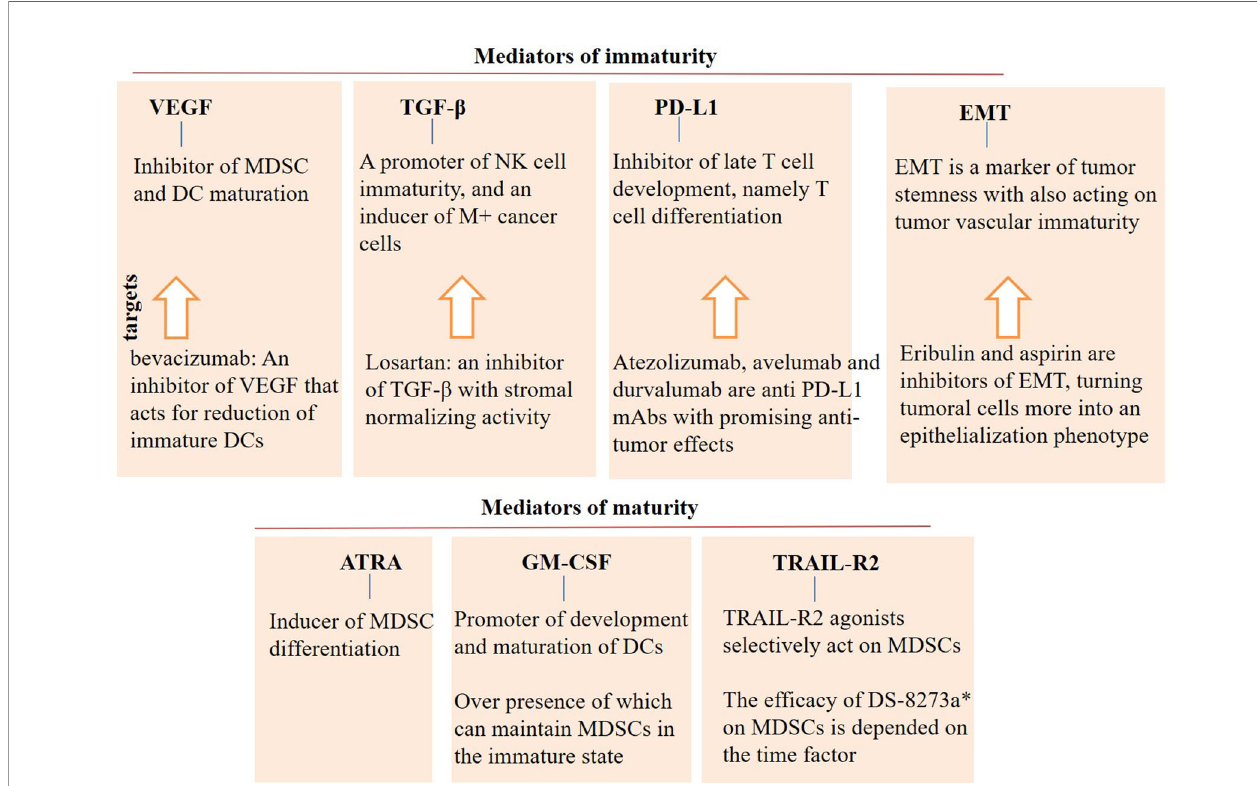
FIGURE 4 | Mediators of (im)immaturity. Vascular endothelial growth factor (VEGF), transforming growth factor (TGF)- b , programmed death ligand-1 (PD-L1), and epithelial-mesenchymal transition (EMT) are mediators of immaturity that contribute to the tumor progression and relapse. By contrast, agents like all-trans retinoic acid (ATRA), granulocyte-macrophage colony stimulating factor (GM-CSF), and TNF-related apoptosis induced ligand-receptor2 (TRAIL-R2) are mediators of maturity that are contributed to cellular differentiation. Agonists of maturity mediators can be an appropriate supplement in the area of immunotherapy. Controversies, however, exist for the use of GM-CSF, which require more research in the area. DC, dendritic cell; MDSC, myeloid-derived suppressor cell; and mAb, monoclonal antibody. *DS-8273a is a TRAIL-R2